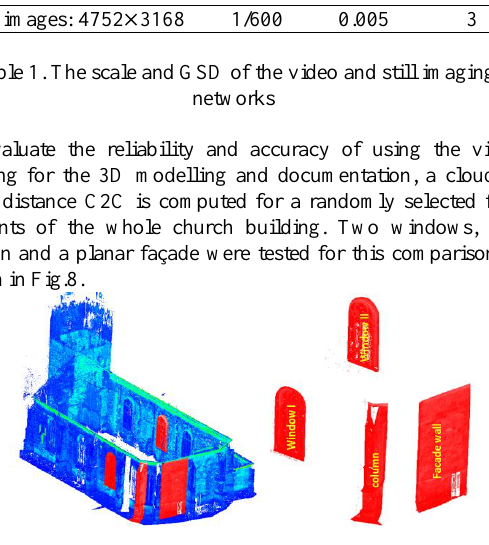
Figure 8. The selected samples (red) of two windows, a column, and a façade for the validation.